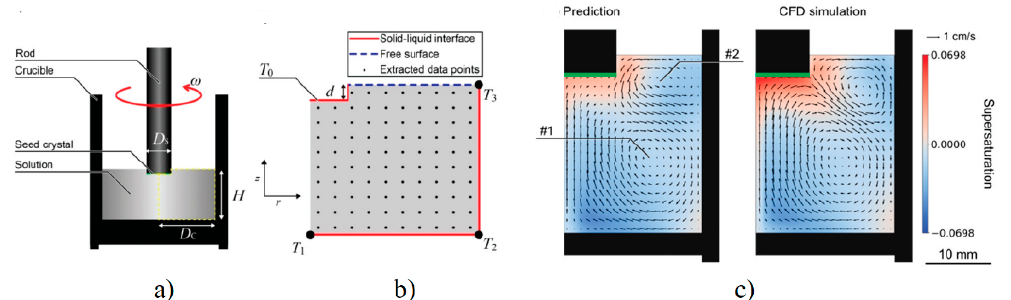
Figure 7. High-speed prediction of CFD simulations of supersaturation and velocity fields in top seeded SiC solution growth (TSSG) using feed forward ANN with 4 hidden layers: ( a ) Configuration of TSSG process, ( b ) computational domain in SiC for CFD, ( c ) Supersaturation and velocity distribution predicted by ANN (left) and by CFD (right). Reprinted from [26] with permission from the Royal Society of Chemistry.